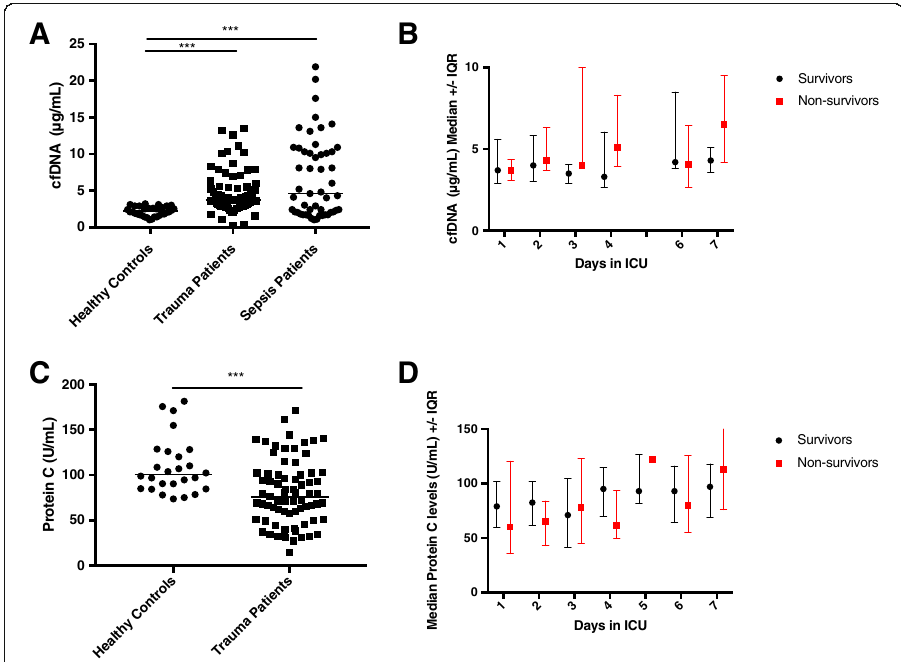
Fig. 1 cfDNA and PC levels in trauma patients. a Median cfDNA levels in trauma patients, septic patients, and healthy controls. b Median and IQR temporal changes in levels of cfDNA in trauma survivors and non- survivors. c Median PC levels in trauma patients and healthy controls. d Median and IQR temporal changes in levels of PC in trauma survivors and non-survivors. Note: *** p < 0.001. IQR = interquartile